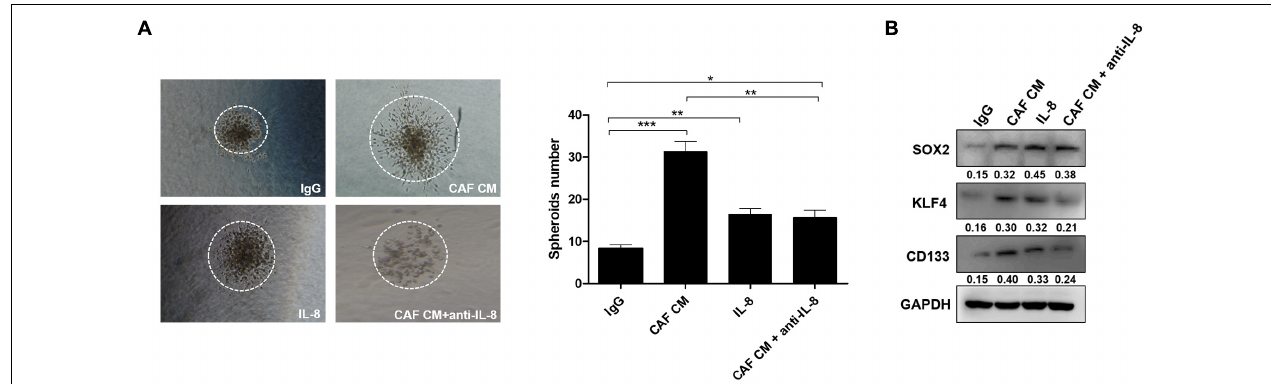
FIGURE 2 | IL-8 secreted from CAFs promotes cancer cell stemness. (A) Spheroids formed by HEY-A8 cells treated with IgG, CAF CM, CAF CM + anti-IL-8, or IL-8. (B) Analysis of KLF4, SOX2, and CD133 expression by Western blotting in HEY-A8 cells treated with IgG, CAF CM, CAF CM + anti-IL-8, or IL-8. GAPDH was used as